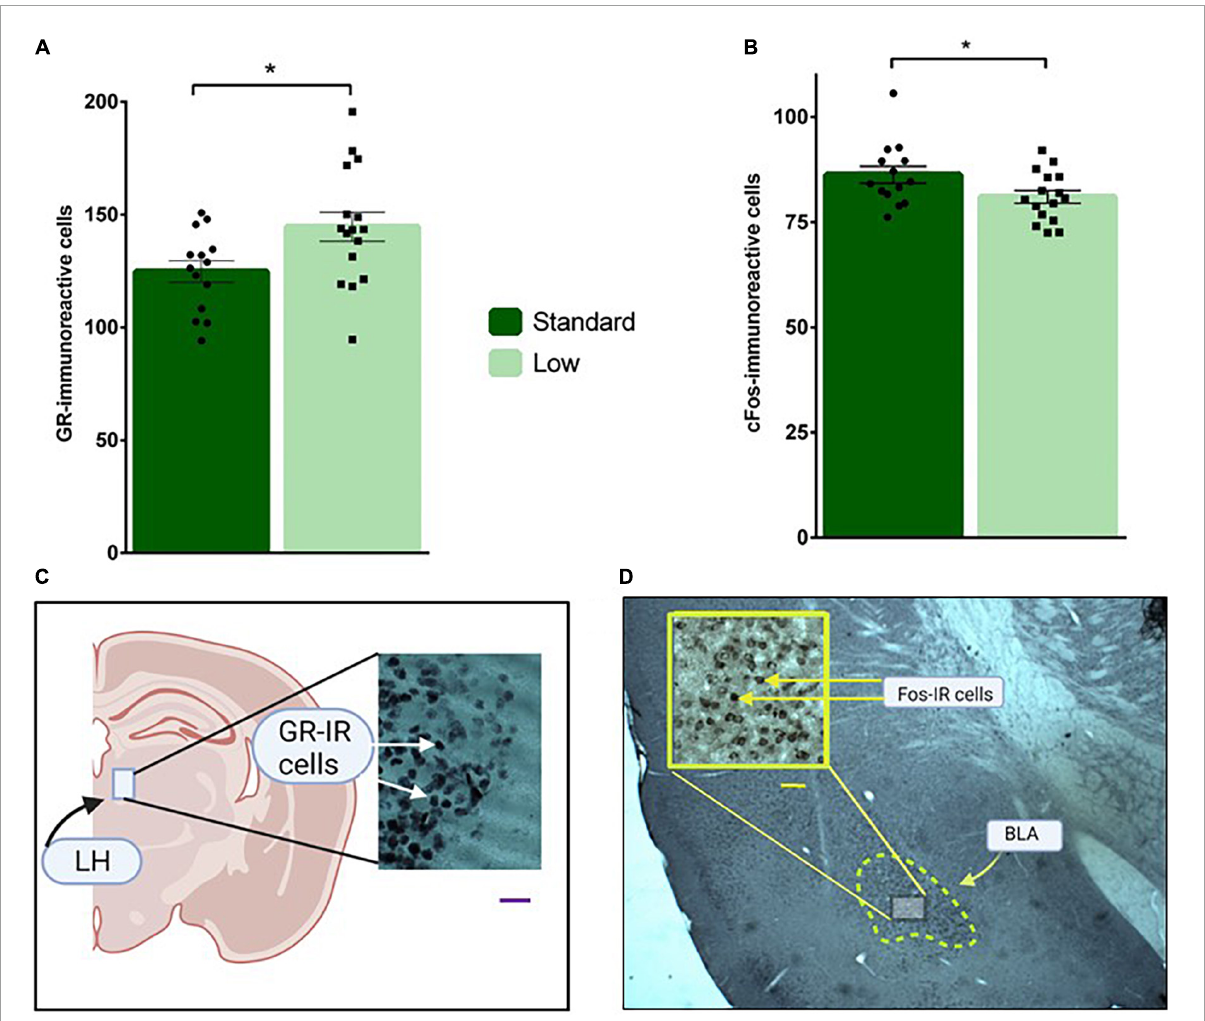
FIGURE11 Immunohistochemical analyses. Brain sections were stained for glucocorticoid receptor in the LH (A) , and c-Fos immunoreactivity in the BLA (B) and analyzed using a two-way ANOVA. (A) Low resource rats were found to have increased glucocorticoid receptor immunoreactivity in neurons located in the lateral habenula compared to standard resource rats (* p = 0.032). (B) Standard resource rats were found to have increased c-Fos-immunoreactive cells in the basolateral amygdala compared to low resource rats (* p = 0.035). No sex differences were detected for either target of interest. For (A,B) : n = 16 for SR group; n = 14 for LR group. (C) Representative photomicrographs of GR-IR cells in the lateral habenula (LH); scale bar = 20 µ m. (D) Representative photomicrograph of c-Fos-IR cells in the basolateral amygdala (BLA); scale bar = 50 µ m. Data are represented as individual data points and bars show means ± SEM. See Supplemental Figure 1 for photomicrographs of negative control for GR- and